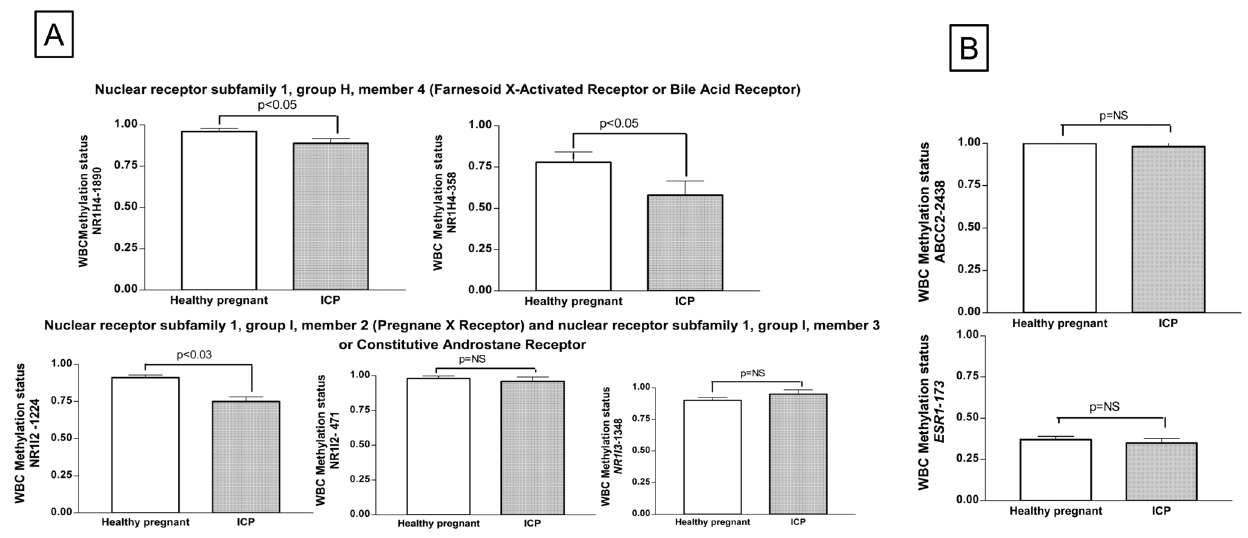
Figure 1. Exploration of methylation status at the 5 9 -cytosine residues of selected dinucleotide CpGs in the gene promoter of FXR / NR1H4 ( 2 358 and 2 1890), PXR / NR1I2 ( 2 471 and 2 1224), NR1I3 ( 2 2377), ESR1 ( 2 173), and ABCC2 ( 2 2438) located at positions relative to transcription starting site. A: Methylation levels of CpG dinucleotides at the gene promoter of nuclear receptor subfamily 1 members ( FXR / NR1H4 2 358 and 2 1890, PXR / NR1I2 2 471 and 2 1224, and NR1I3 2 2377) in normal healthy pregnancy and in patients with ICP. B: Methylation levels of CpG dinucleotides at the gene promoter of ATP-binding cassette (ABC) transporter ABCC2 -2438 and ESR1 -173 in normal healthy pregnancy and in patients with ICP.